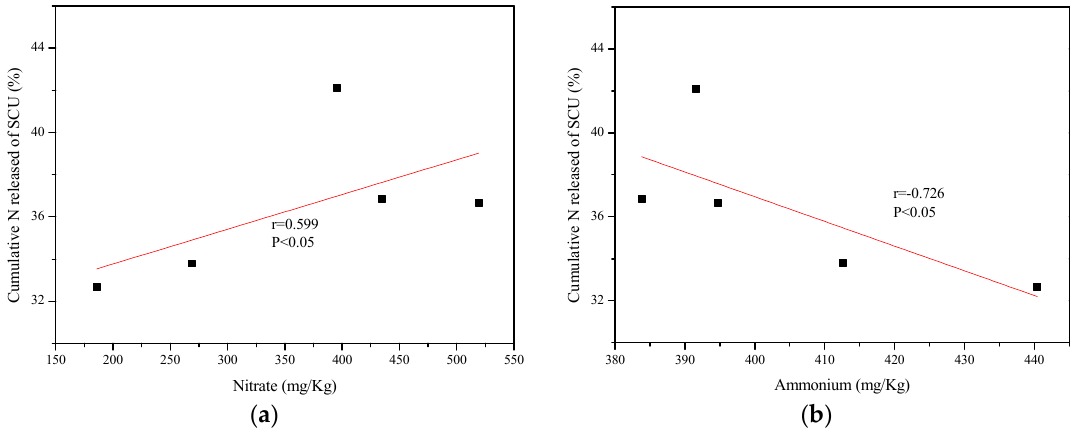
Table 6. Linear predictive models for predicting the N release of controlled release urea (CRU). Regression Equation